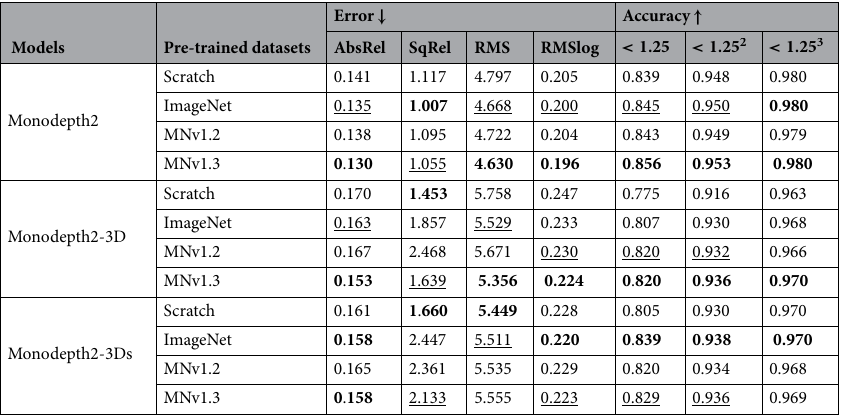
Table 3. Quantity results of various MDE models in KITTI with different pre-trained datasets. The best result are bolded and the second best are underlined. Since we have only 10 epochs of fine-tune and without masking mechanism, the results are different from the original paper of monodepth2 20